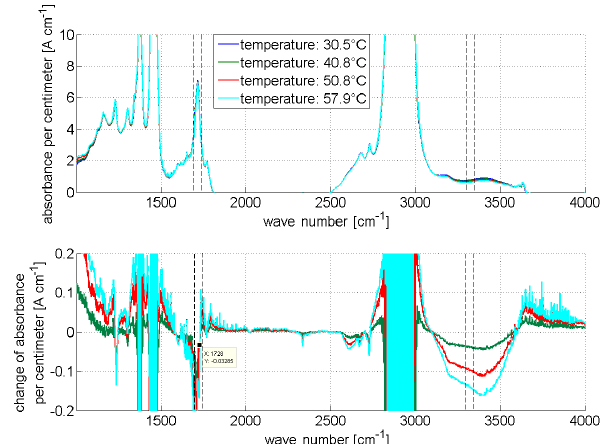
Figure 12. Temperature dependence of the FTIR spectra. Top: Transmission spectra for synthetic motor oil (artificially aged at 170 ◦ C with 50cm 3 min − 1 air flow over 9 days with 0.4wt.% wa- ter contamination added after aging) at 30.5, 40.8, 50.8 and 57.9 ◦ C. Bottom: Deviation of the transmission spectra at elevated tempera- tures relative to the transmission at 30.5 ◦ C; areas for calculating the mean values around 1722 and 3333cm − 1 shown in Fig. 13 are marked.